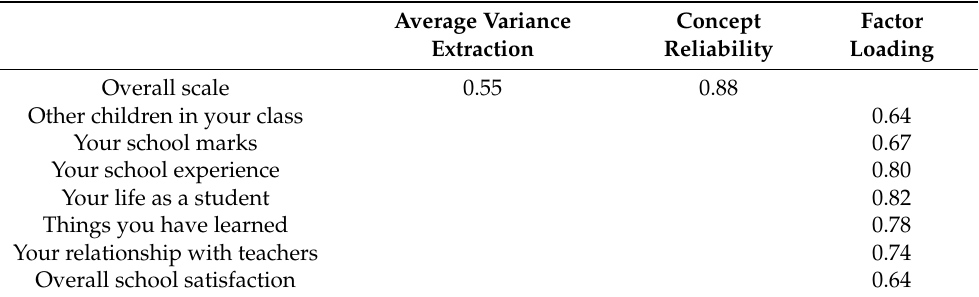
Table 2. Factor loadings of the indicators of school satisfaction, Average Variance Extraction and Composite